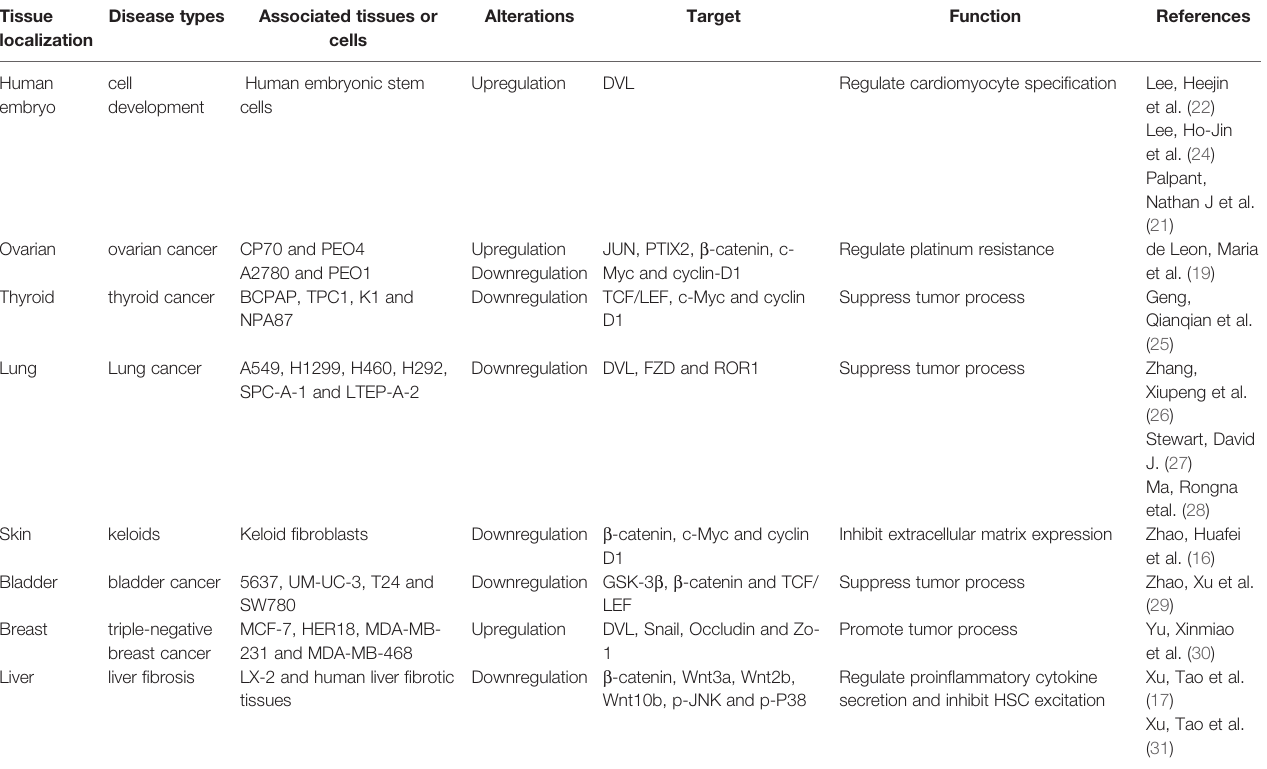
TABLE 1 | The landscape of the roles of TMEM88 in various human